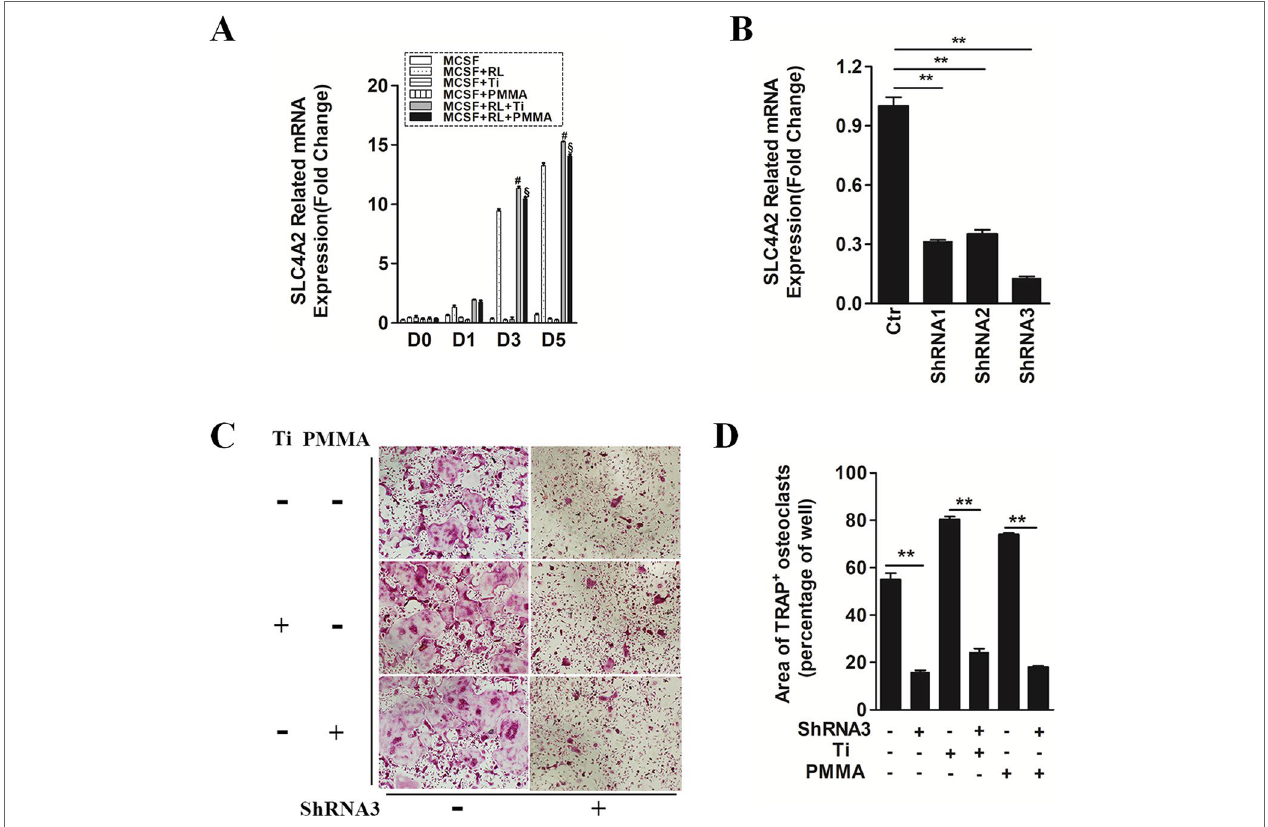
FIGURE 1 | SLC4A2 plays an important role in wear particle-induced osteoclastogenesis. (A) Up-regulation of Slc4a2 gene expression in the process of wear particle-induced osteoclastogenesis. Bone marrow-derived macrophages (BMM) were used [#, MCSF+RANKL(RL)+Ti vs. MCSF+RL, P < 0.01; §, MCSF+RL+PMMA vs. MCSF+RL, P < 0.01]. (B) Three different shRNA vectors targeting Slc4a2 , with shRNA3 yielding the greatest reduction in Slc4a2 mRNA. Effective knockdown of Slc4a2 in BMM cells, at 48 h after transfection using Slc4a2 shRNA1, shRNA2 and shRNA3, respectively. After transfection, cells were induced to differentiate into osteoclasts and harvested to examine Slc4a2 expression using reverse transcription quantitative PCR (RT-qPCR). (C) Effect of knockdown of Slc4a2 , using shRNA3, on wear particle-induced osteoclastogenesis in vitro . (D) The area of TRAP-positive cells, measured using ImageJ (* P < 0.05; ** P < 0.01). At least three independent replicated of each experiment were conducted